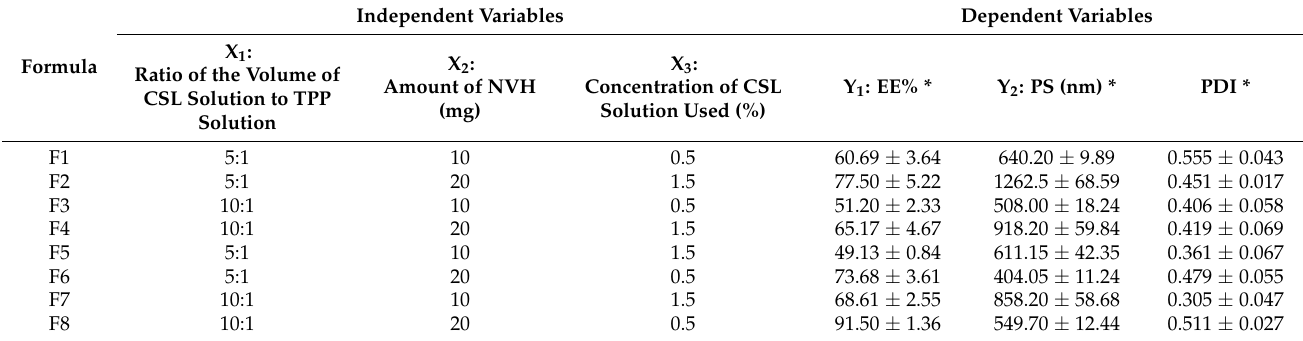
Table 2. Formulations of the experimental design and their response